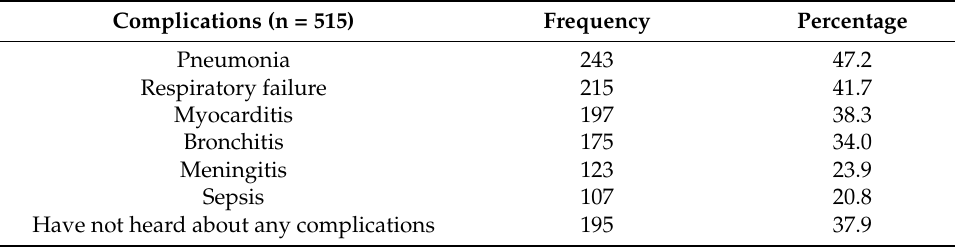
Table 8. Participants’ knowledge about the influenza complications in